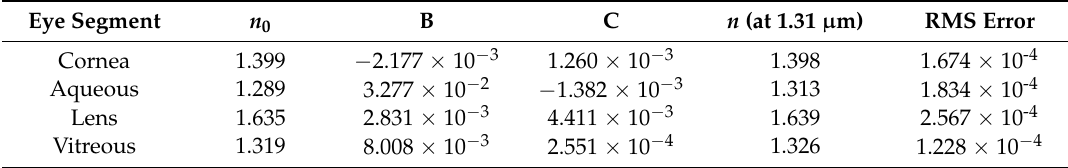
Table 2. Conrady parameters for the murine ocular media.